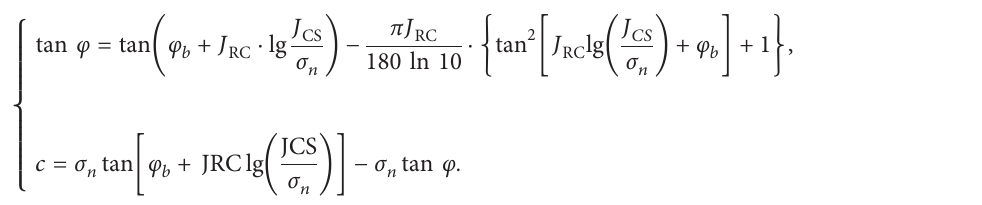
− τ ) . (d) Linear relationship ( τ p ult